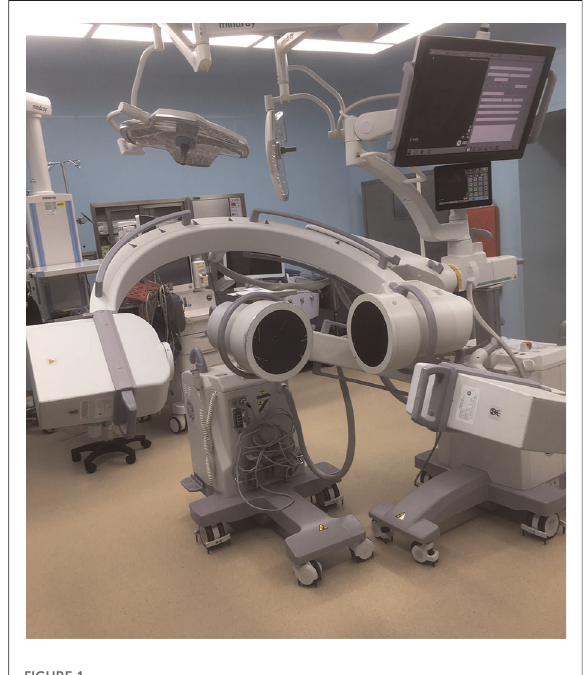
FIGURE 1 Two fl uoroscopes were positioned with their image intensi fi ers kept perpendicular to each